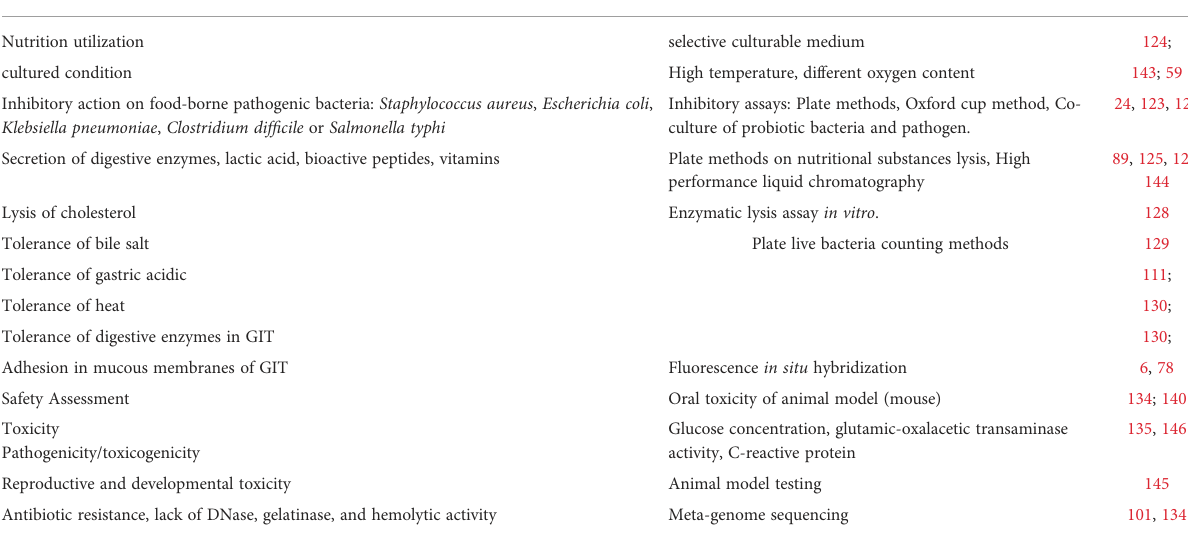
TABLE 2 Strategy of the isolating